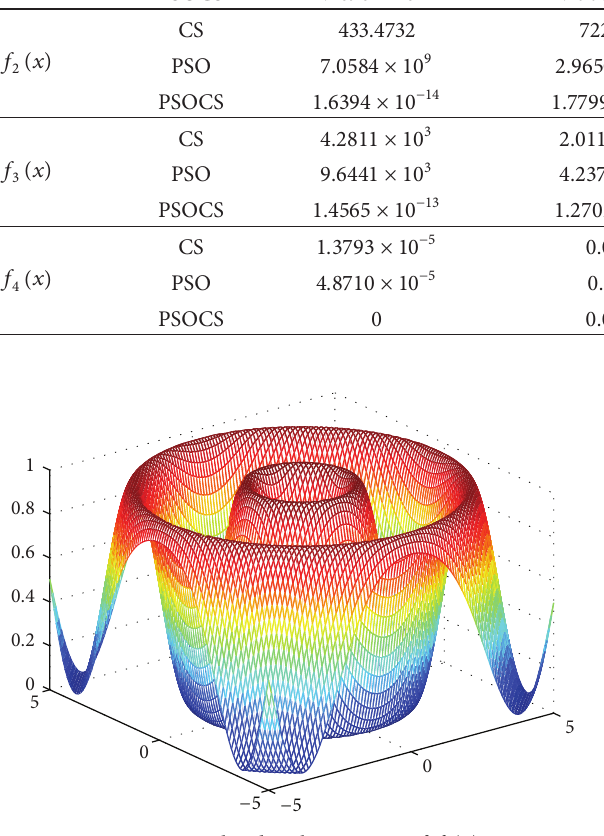
Figure 3: Value distribution map of 𝑓 4 (𝑥)